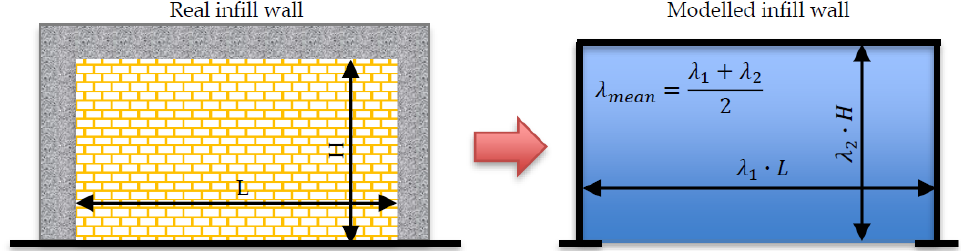
Figure 4. Geometrical assumption for the infill modelling within a frame